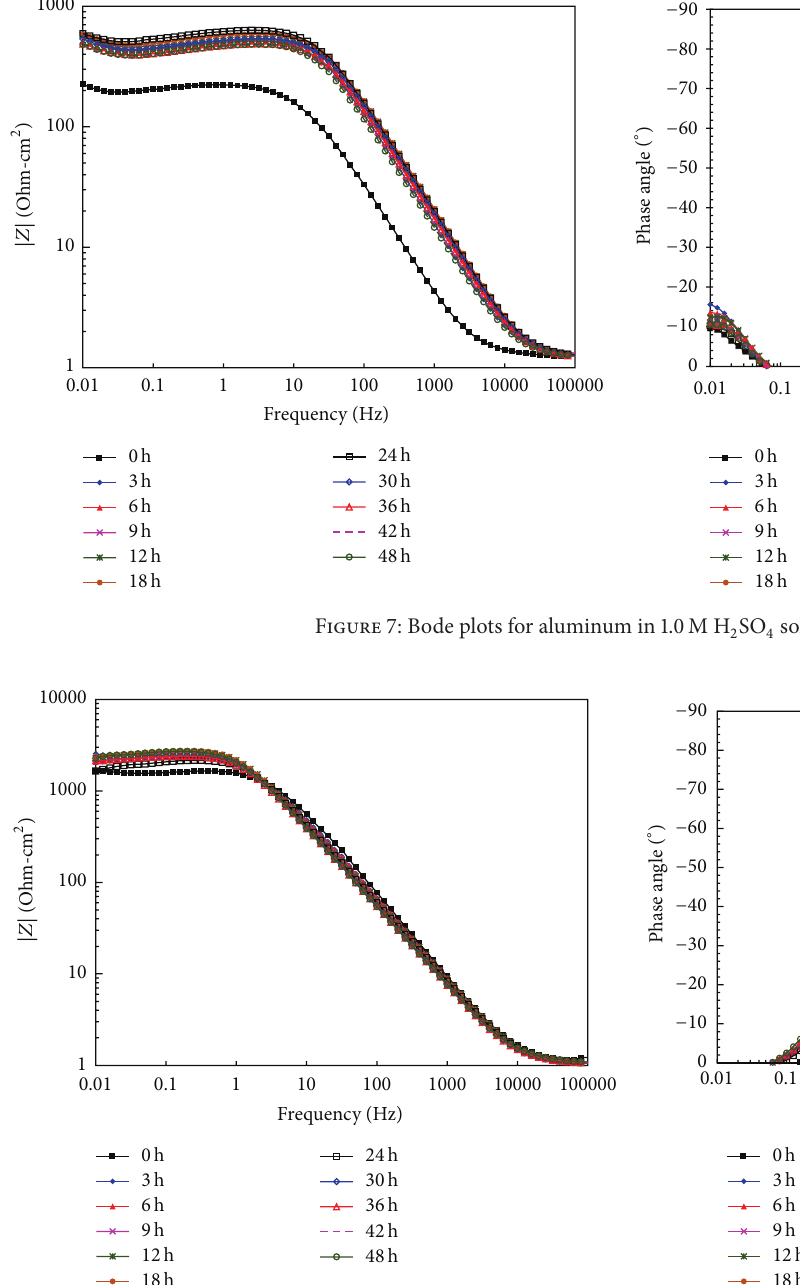
Figure 8: Bode plots for Ni 3 Al in 1.0M H 2 SO 4 solution at 25 ∘